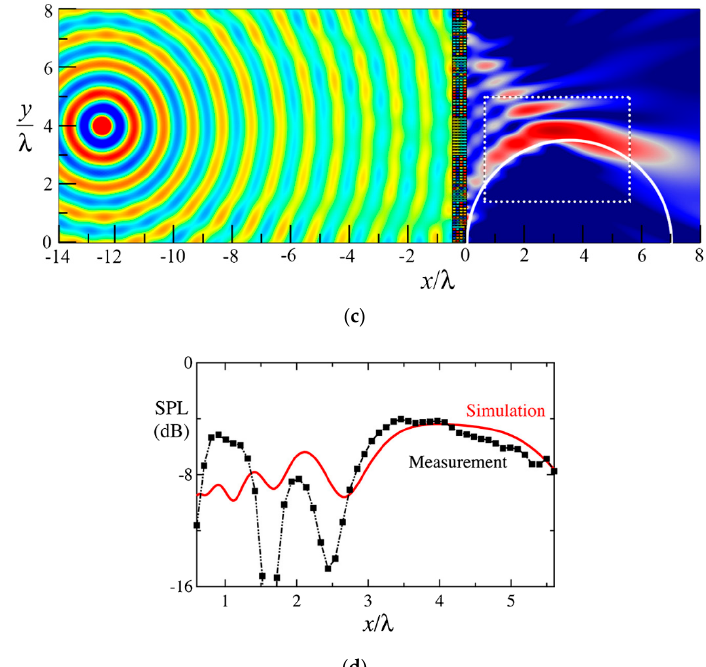
Figure 19. ( a ) Element design showing a hybrid structure consisting of a straight pipe and four Helmholtz resonators. ( b ) Fabricated samples with eight elementary units. ( c ) Simulated sound field where the field at 𝑥 > 0 is normalized by the maximum value. Comparison of the experimental measurements with numerical simulation along the white-colored trajectory in ( d ). Reprinted with permission from [296] Copyright (2015) by the American Physical Society.